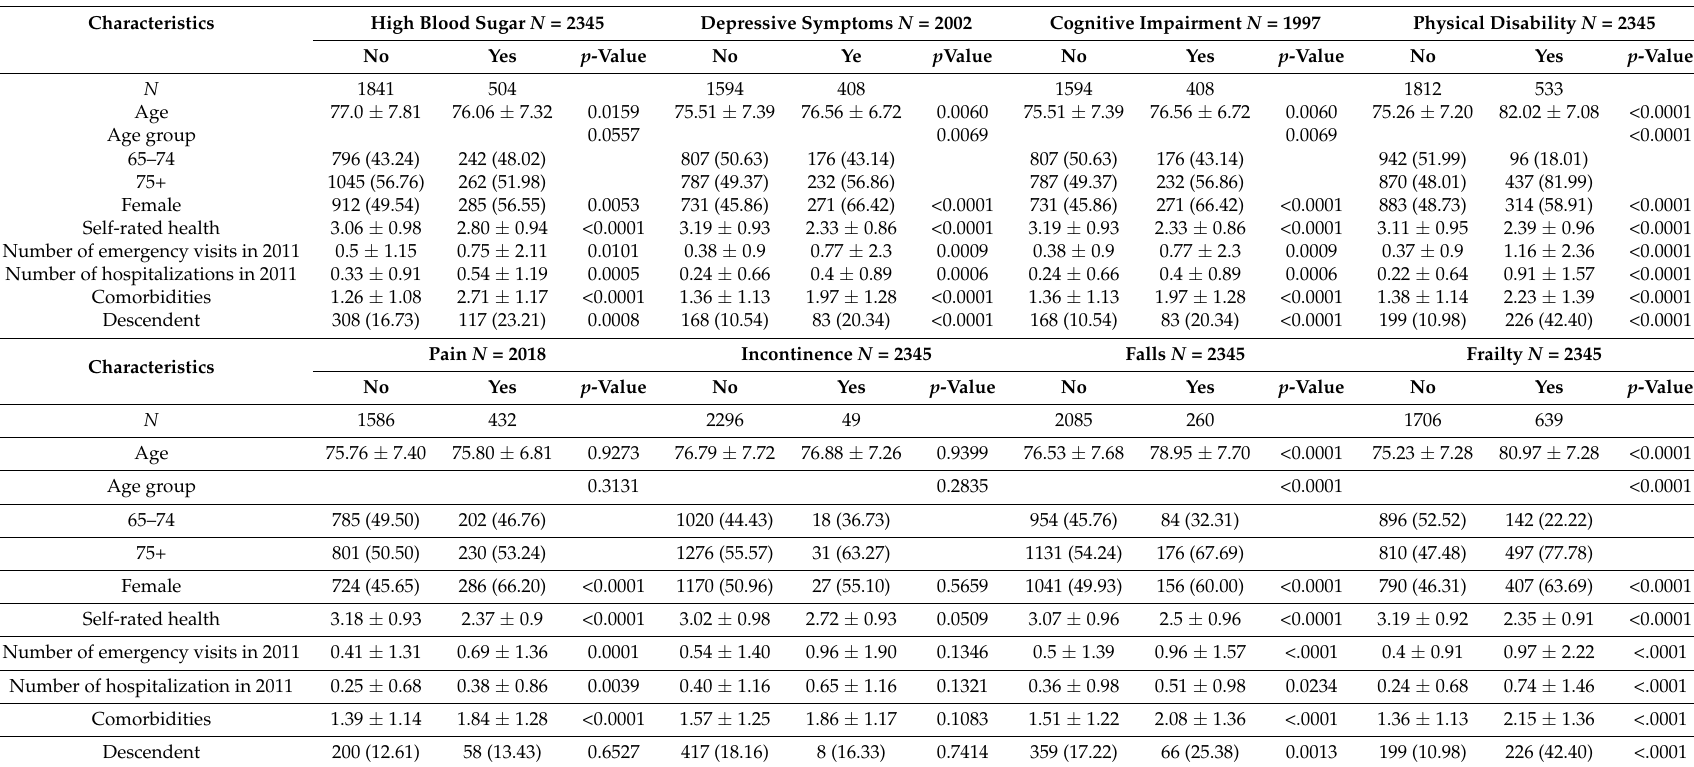
Table 1. Demographic and clinical characteristics of participants with different geriatric syndromes in